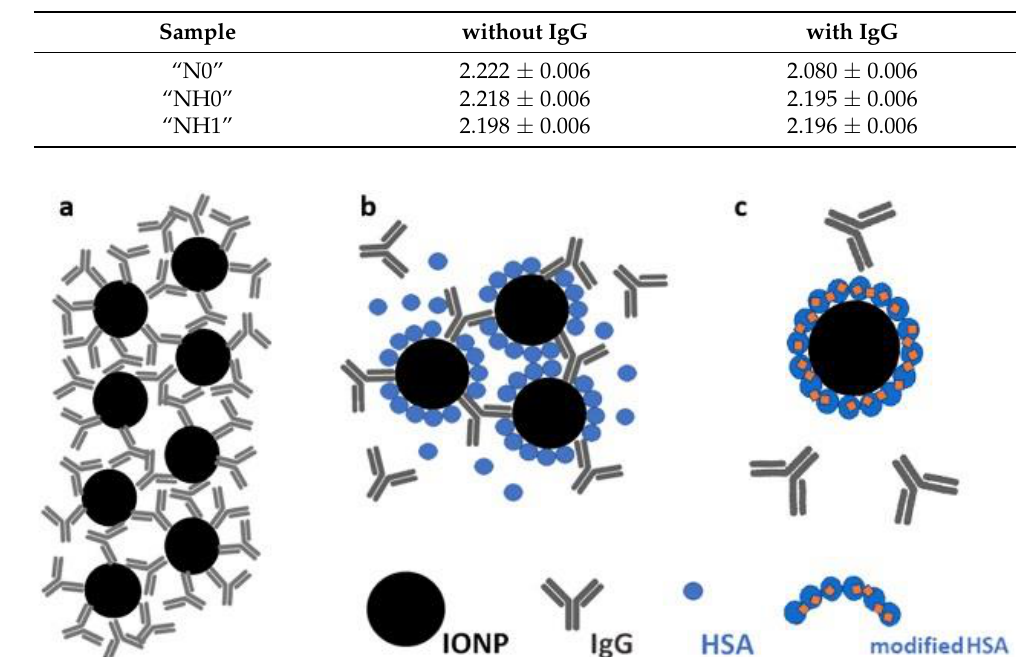
Figure 3. Electron magnetic resonance (EMR) absorption curves of the diluted samples “N0” ( a ), “NH0” ( b ), “NH1” ( c ) before (all solid lines) and after (all dotted lines) the addition of immuno- globulin G. Immunoglobulin G was added after the overnight incubation of samples. The IONP concentration in all of the analyzed samples was 0.05 mg/mL. The resonance field of the correspond- ing spectra before and after the addition of IgG are marked in the figure. Table 1. Experimental g-factors of the EMR signals of IONPs in samples with and without immu- noglobulin G (IgG).